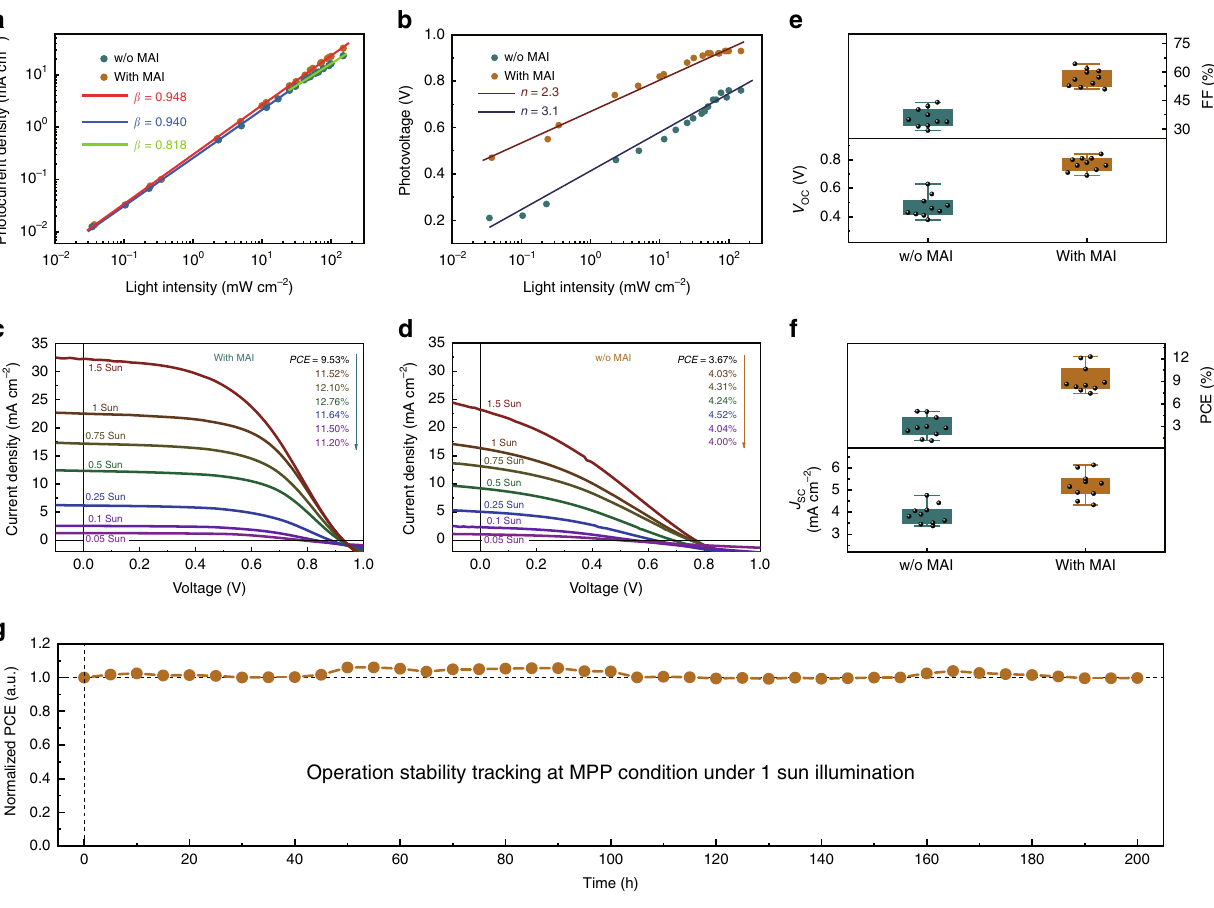
Fig. 6 Device performance of lateral-structure solar cells. a Light intensity (0.0005 – 1.5 Sun) dependence of J sc curves. b Light intensity (0.0005 – 1.5 Sun) dependence of V OC curves. J - V curves of different light intensity with ( c ) and without ( d ) MAI treatment. e and f Statistical data of device performance before and after MAI treatment (0.25 Sun). g Long-term stability under continuous output at MPP condition (1